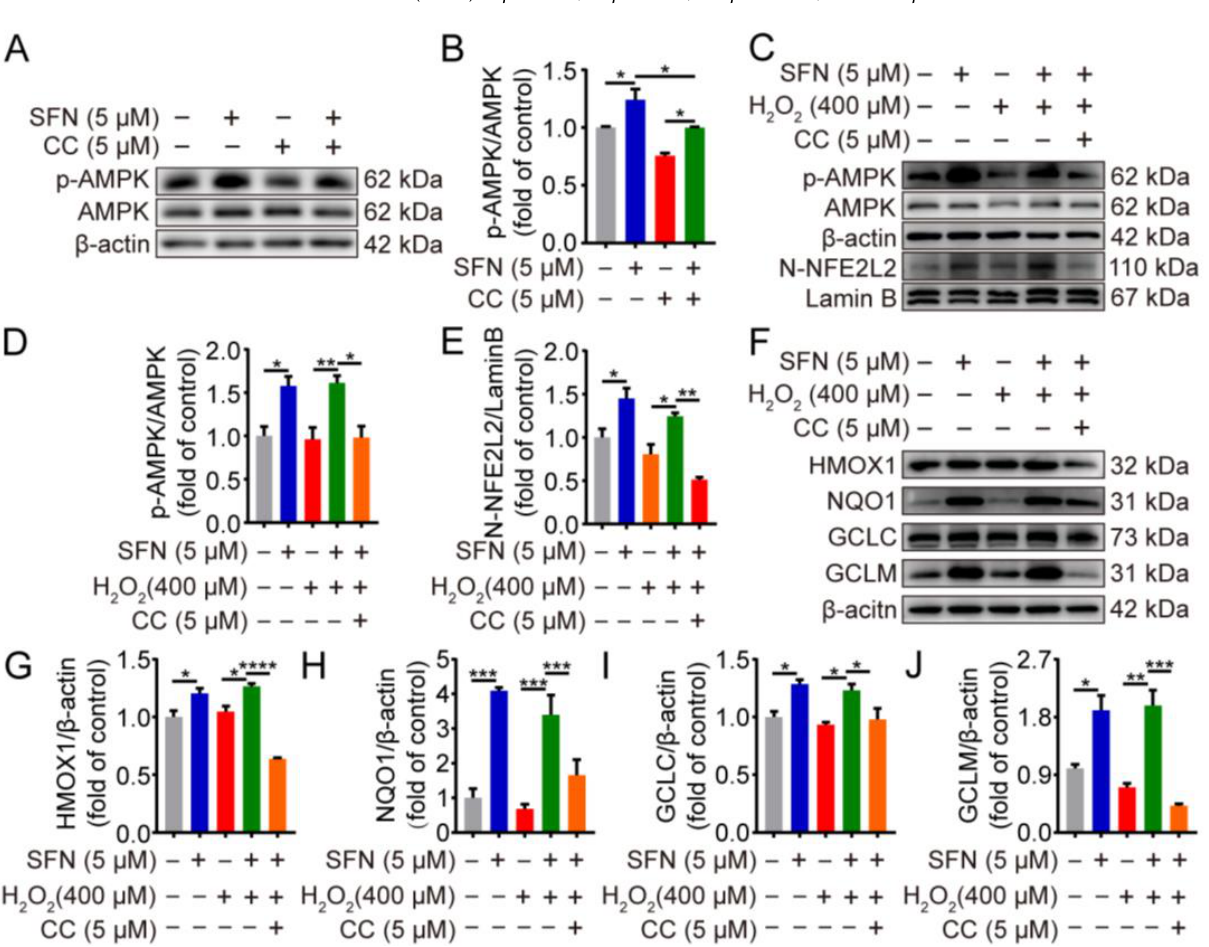
Figure 5. The antioxidant effects of SFN are mediated through AMPK/NFE2L2 pathway in H 2 O 2 - induced GMECs. GMECs were treated with compound C (5 µ M) for 4 h in advance and/or were treated with SFN (5 µ M) for 24 h before exposed to H 2 O 2 (400 µ M) for 24 h. ( A ) AMPK phosphory- lation levels in SFN-treated cells were detected using Western blot analysis. ( C ) p-AMPK, NFE2L2 protein expression levels were determined by Western blot from SFN-treated cells supplementation with compound C under oxidative stress. ( F ) HMOX1, NQO1, GCLC, and GCLM protein levels were detected by Western blot from SFN-treated cell supplementation with compound C under oxidative stress. ( B , D , E , G – J ) Quantitative analysis of p-AMPK, NFE2L2, HMOX1, NQO1, GCLC, and GCLM protein levels. One-way ANOVA, Tukey’s post hoc test. Data are the mean ± SEM ( n = 3). * p < 0.05, ** p < 0.01, *** p < 0.001, and **** p < 0.0001.